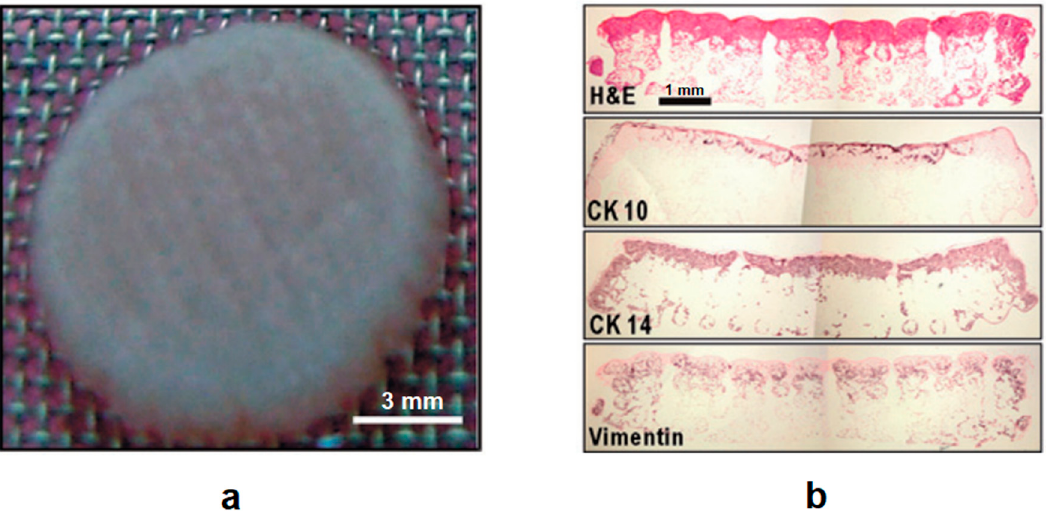
Figure 5. ( a ) Optical image of a collagen scaffold (diameter, 8 mm; thickness, 2 mm) after cell culturing with keratinocytes and fibroblasts; and ( b ) cross-sections with hematoxylin and eosin staining (top) and immunohistochemical detection of cytokeratin (CK10) and (CK14) (middle), and vimentin (bottom). Reproduced with permission from G. H. Kim et al., Journal of Materials Chemistry; published by Royal Society of Chemistry, 2009 [88].